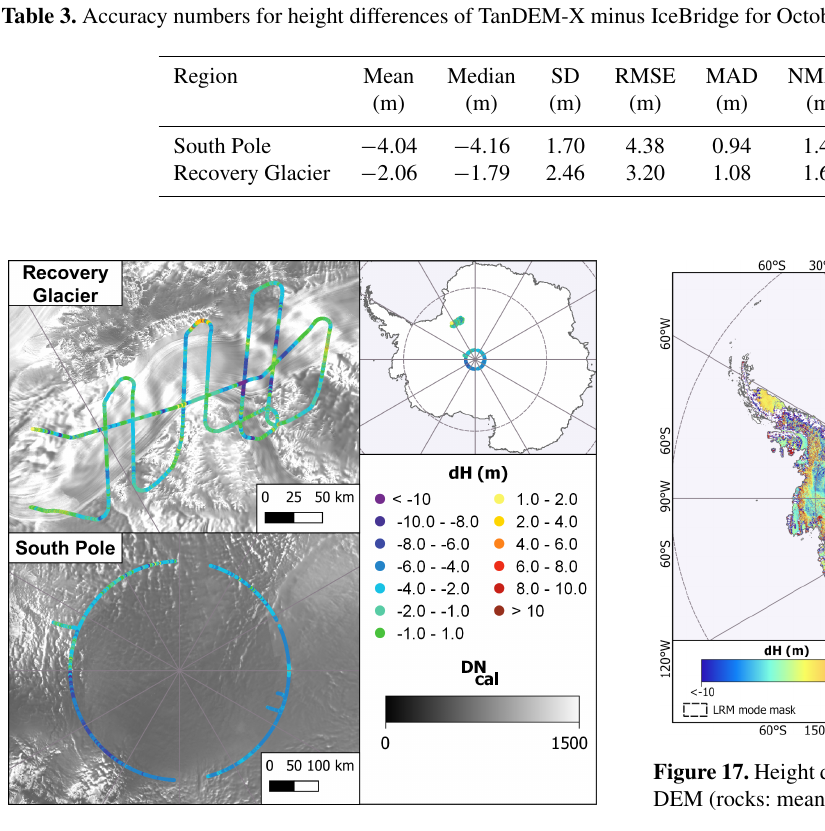
Figure 16. Height differences of TanDEM-X DEM minus Ice- Bridge from October 2014 campaigns over the South Pole and the Recovery Glacier displayed over the amplitude mosaic.